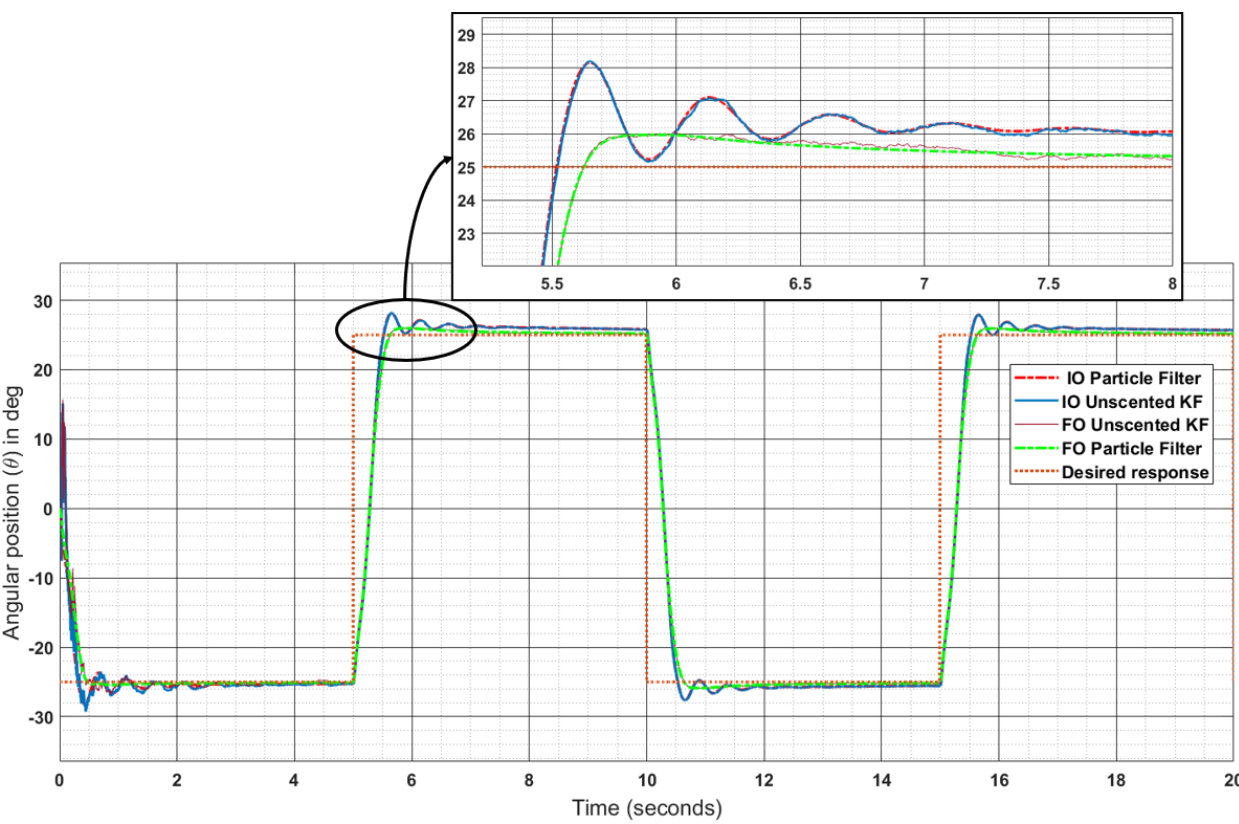
Figure 11. Integer and fractional order controller comparison for different state estimation methods for Link